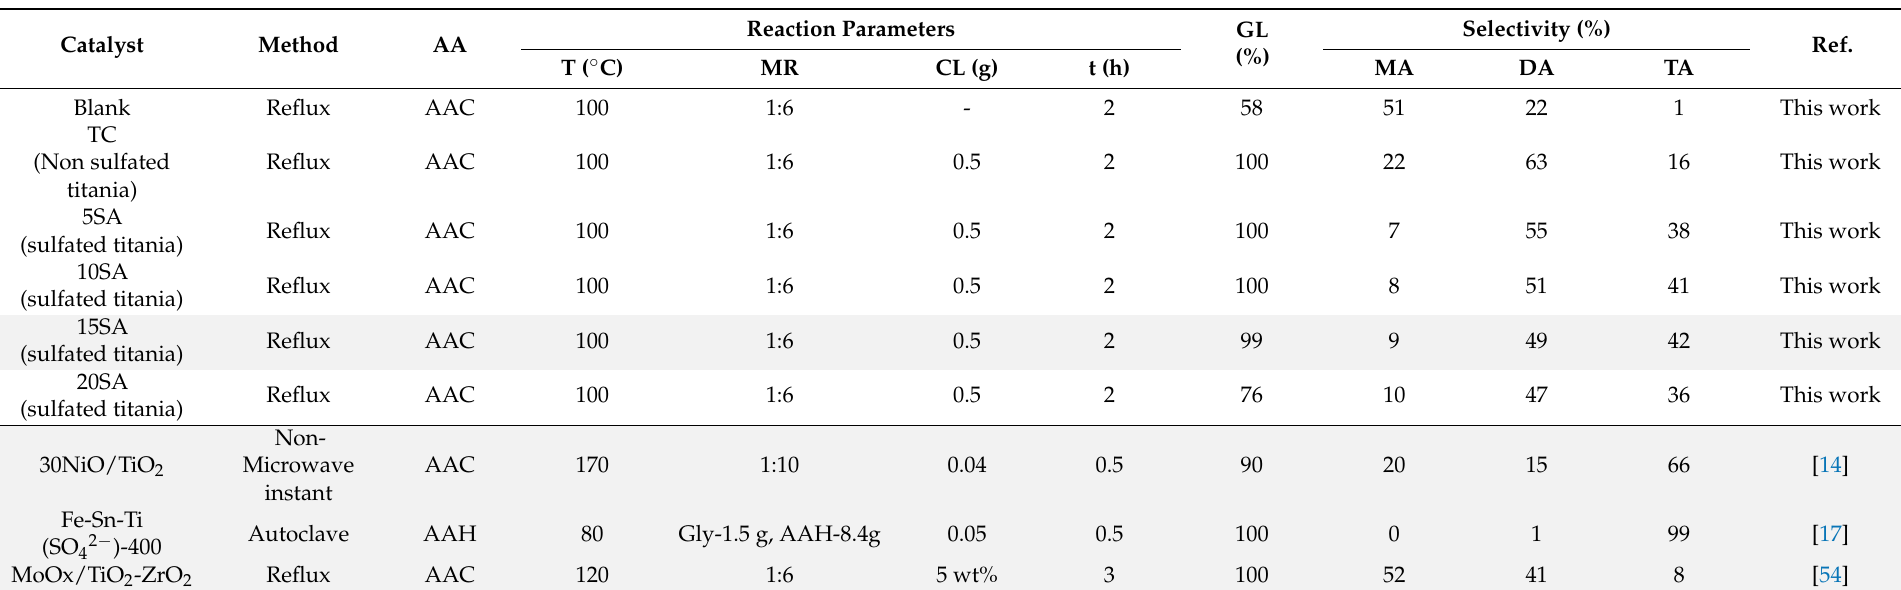
Table 3. Comparative study on glycerol acetylation using titania catalysts and